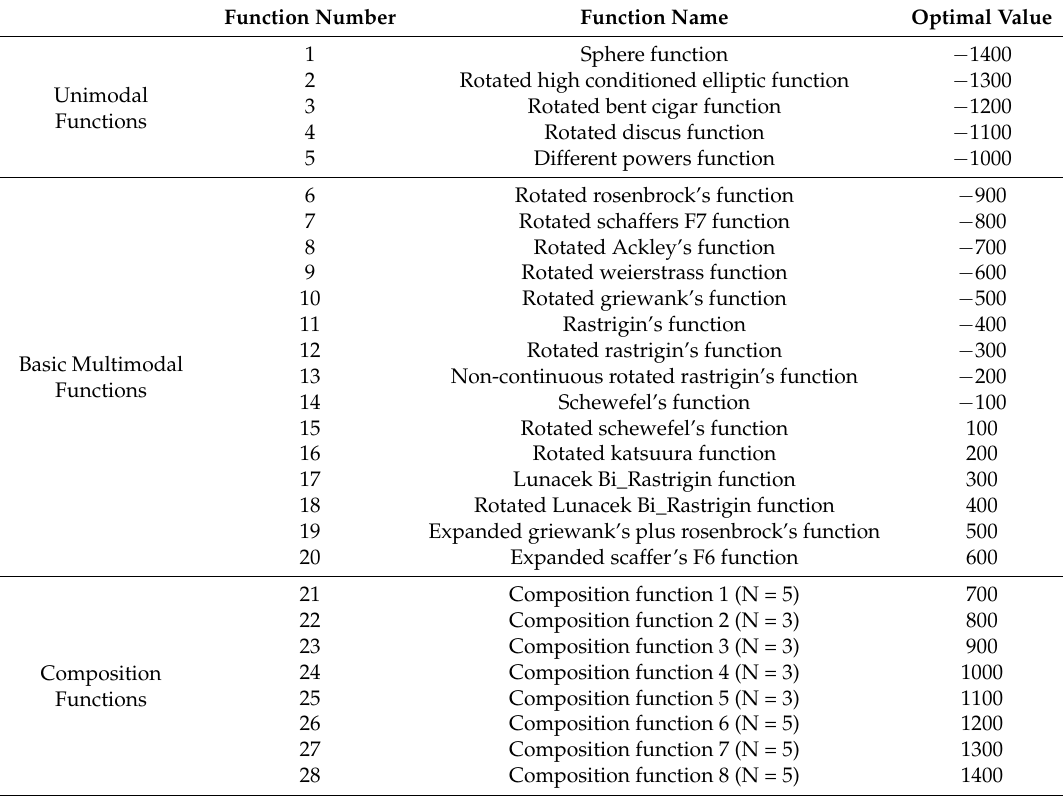
Table 1. CEC2013 test